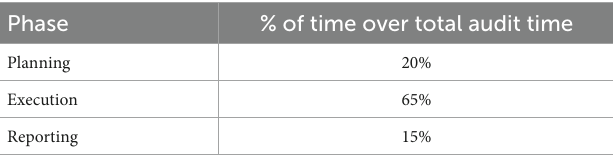
Adapted from the phases proposed by the Institute of Internal Auditors of Spain,